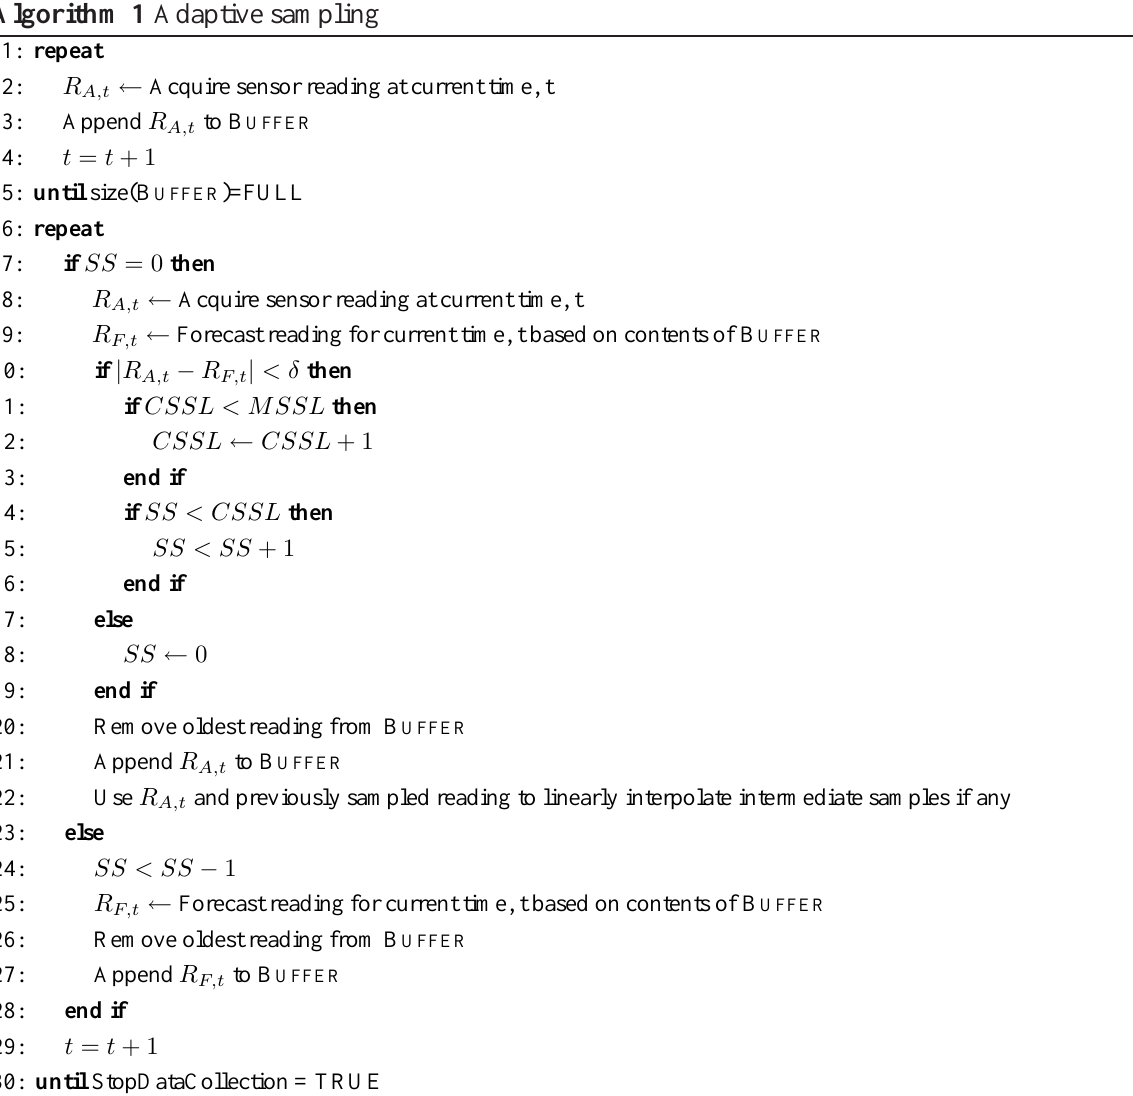
Algorithm 1 Adaptive